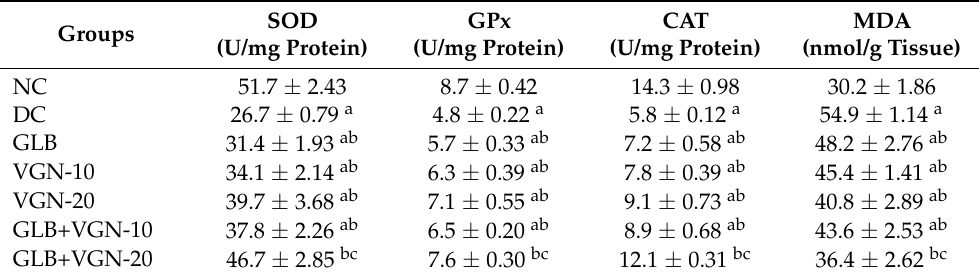
Table 5. Effect of GLB, VGN and their combinations on SOD, GPx, CAT and MDA levels in pancreatic tissues of STZ-induced